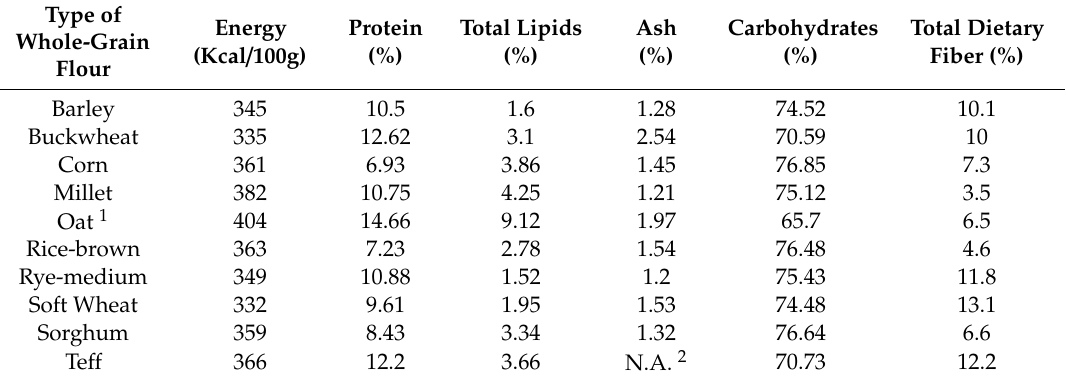
Table 1. Composition of whole-grain flours (adapted from